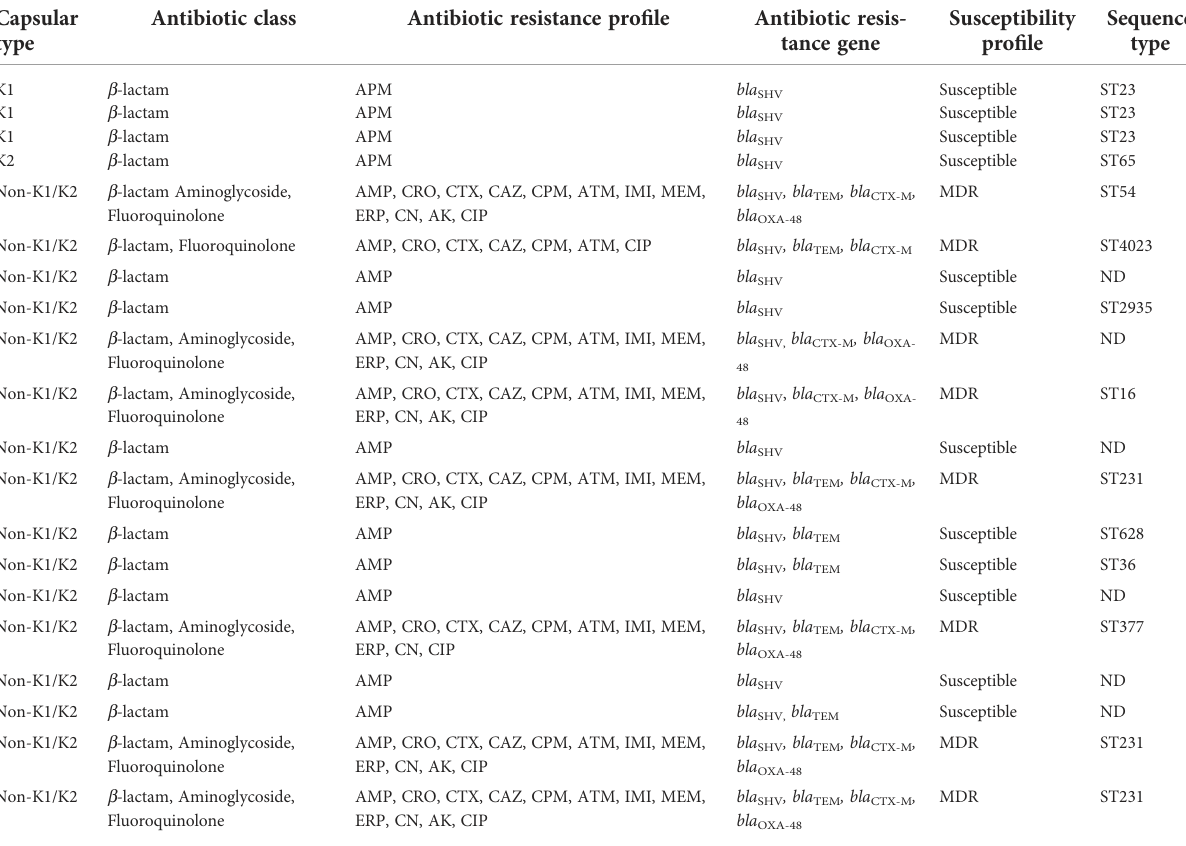
TABLE 3 Antibiotic class, antibiotic resistance pro fi le, antibiotic resistance gene, and susceptibility pro fi le in 20 K . pneumoniae isolates from cryptogenic and non-cryptogenic liver abscesses.